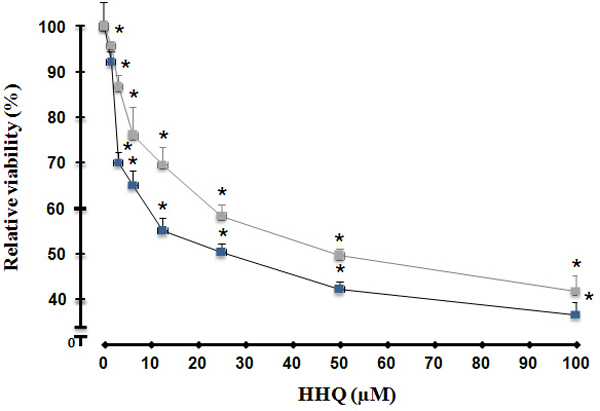
Growth curve inhibition as assessed by MTT assay in human breast cancer cells (MDA-MB-231 (blue line) and MCF-7 (grey line)). The breast cancer cells were exposed to different doses of HHQ for 48 h at 37 °C. The cell viability in breast cancer cells decreased in dose-dependent fashion. The IC-50 value for MDA-MB-231 and MCF-7 were observed to be 25 μM and 50 μM, respectively. Data are representative of three independent experiments done in triplicates and expressed as mean ± S.E.M. *p < 0.005 represents statistical significant difference between control and HHQ test groups.